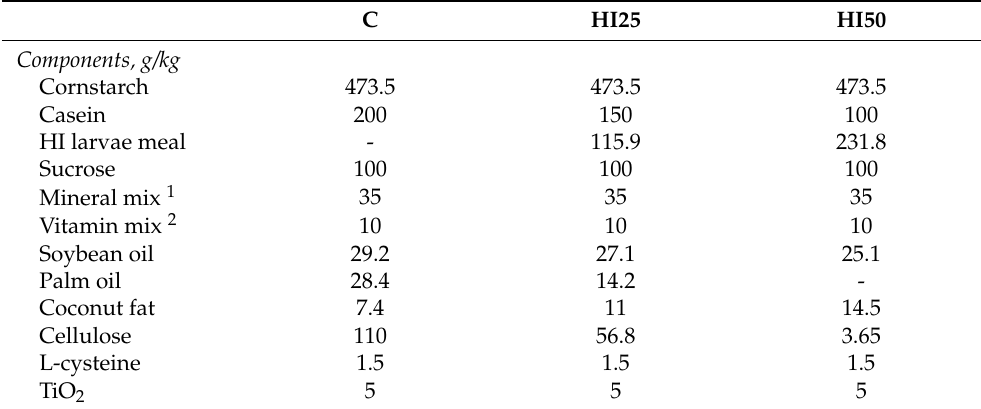
Table 1. Composition of the experimental diets.